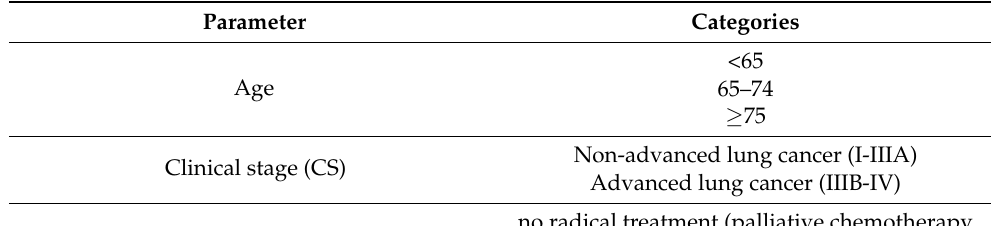
Table 2. The categories used in the